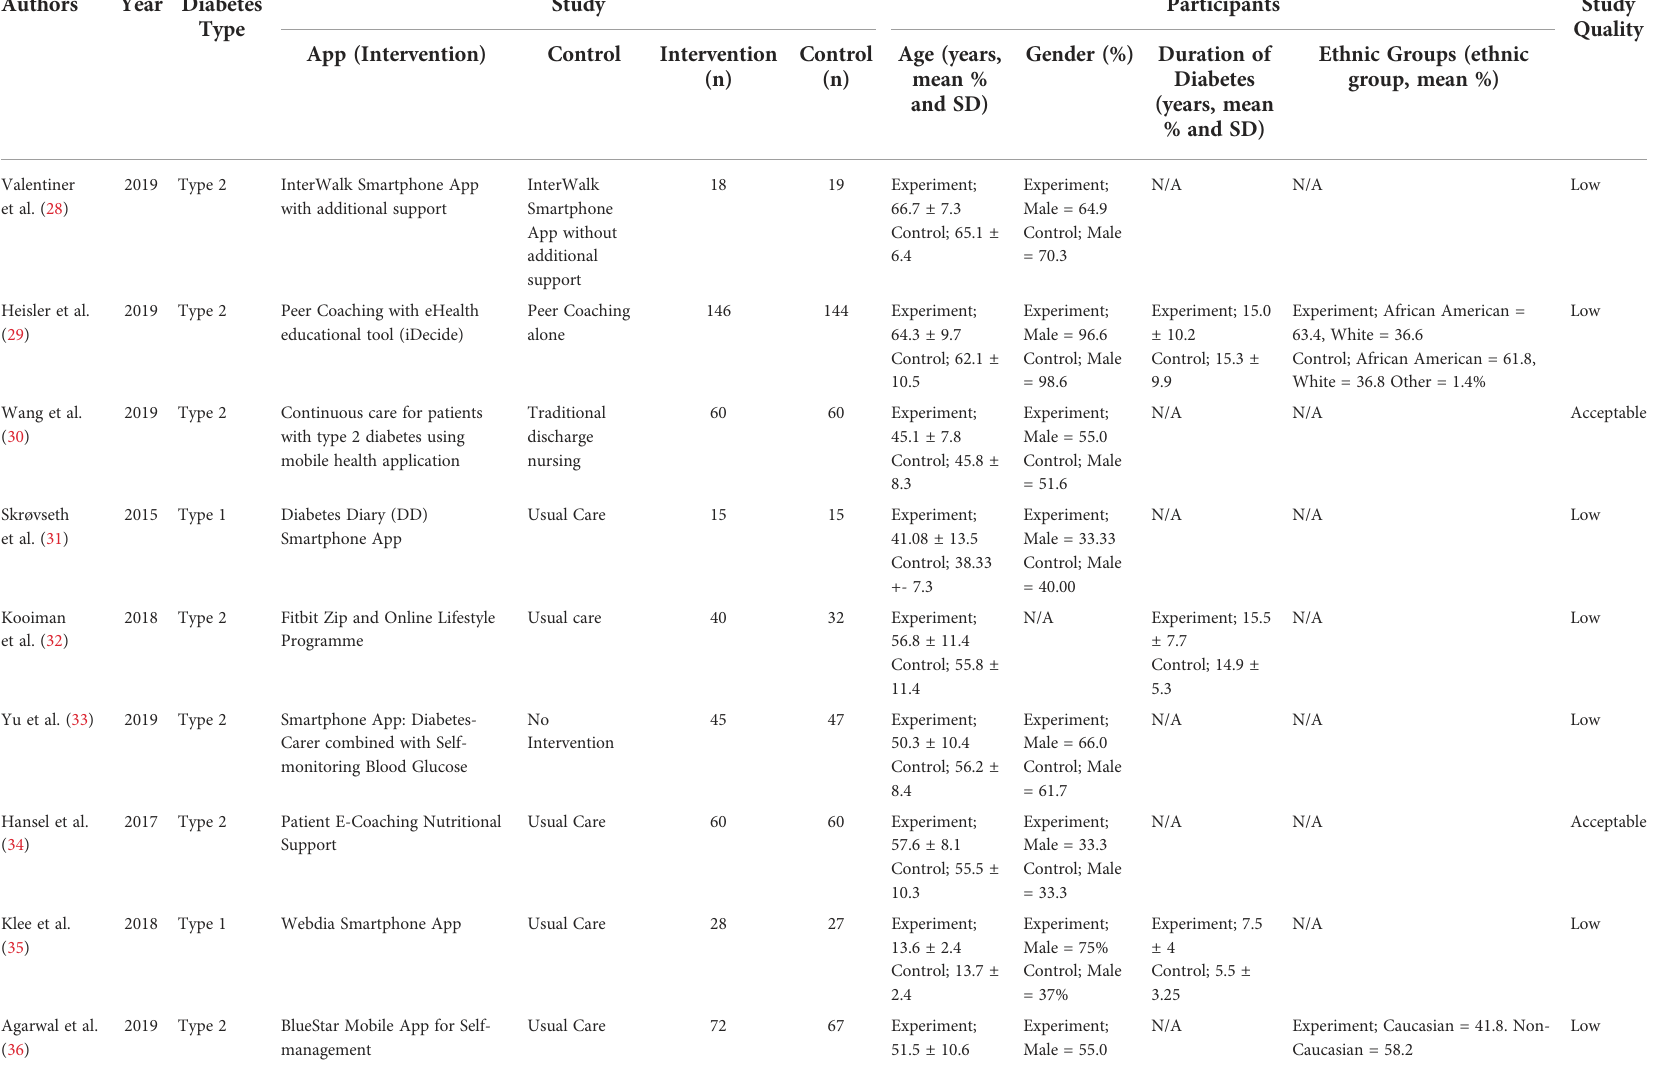
TABLE 3 Characteristics of included